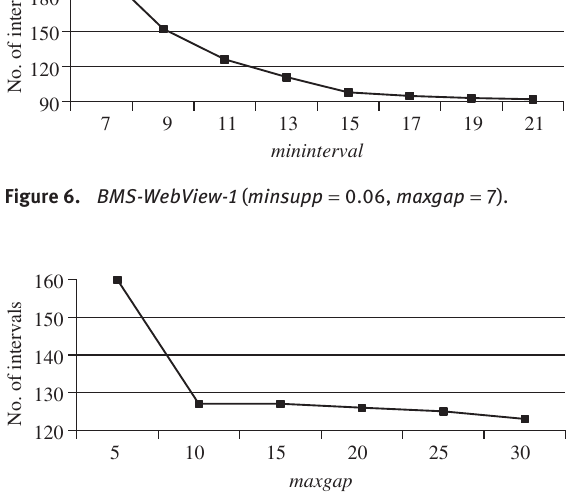
Figure 7. retail ( minsupp = 0.25, mininterval =